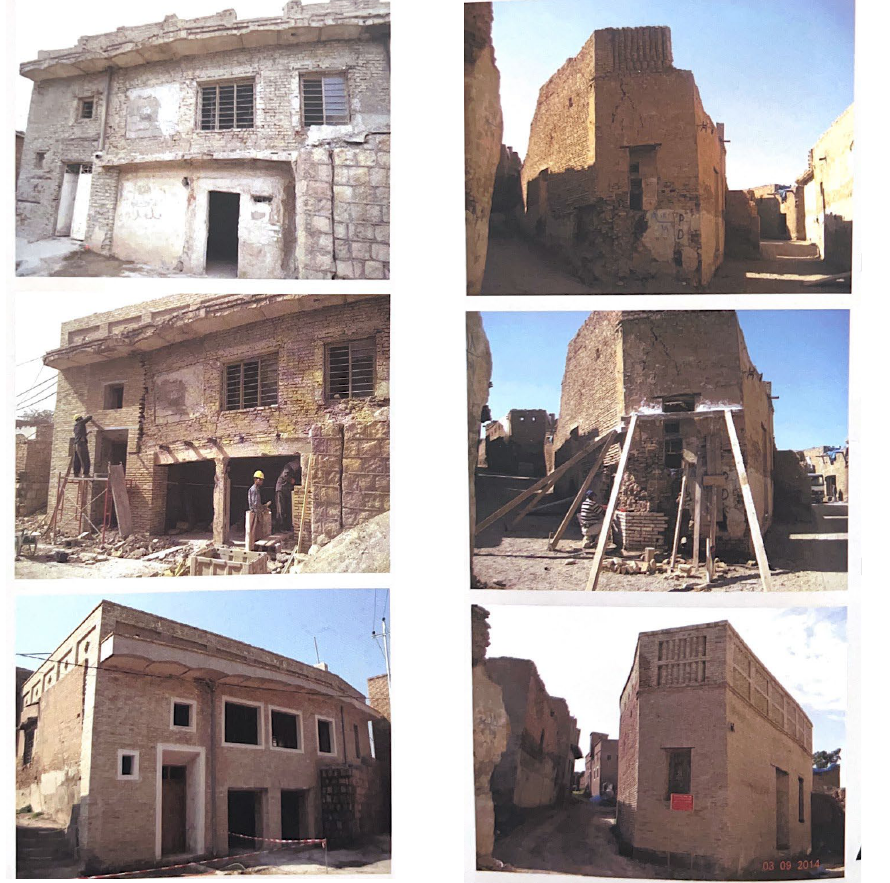
Figure 15. Examples of house renovation and restoration in the citadel [136].